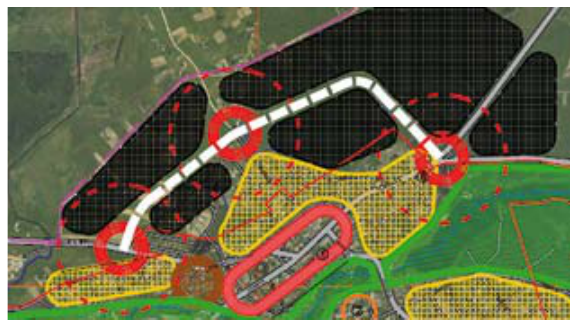
Fig. 1. Analizing territory of Molėtai town Signal controlled intersections